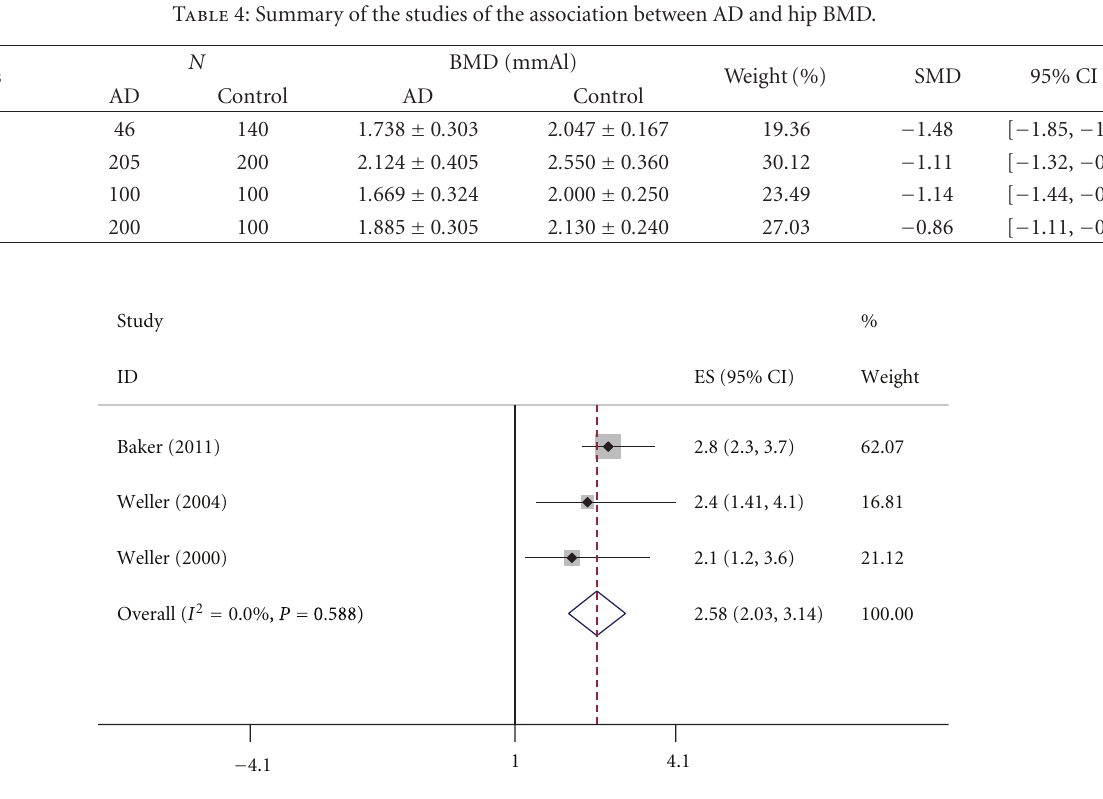
Figure 2: Pooled estimate of ES and 95% CI of AD and hip fracture (used OR and 95% CI fixed). ES is represented by squares, whose sizes are proportional to the sample size of the relative study. The whiskers represent the 95% CI. The diamond represents the pooled estimate based on the random e ff ects model, with the centre representing the point estimate and the width the associated 95%